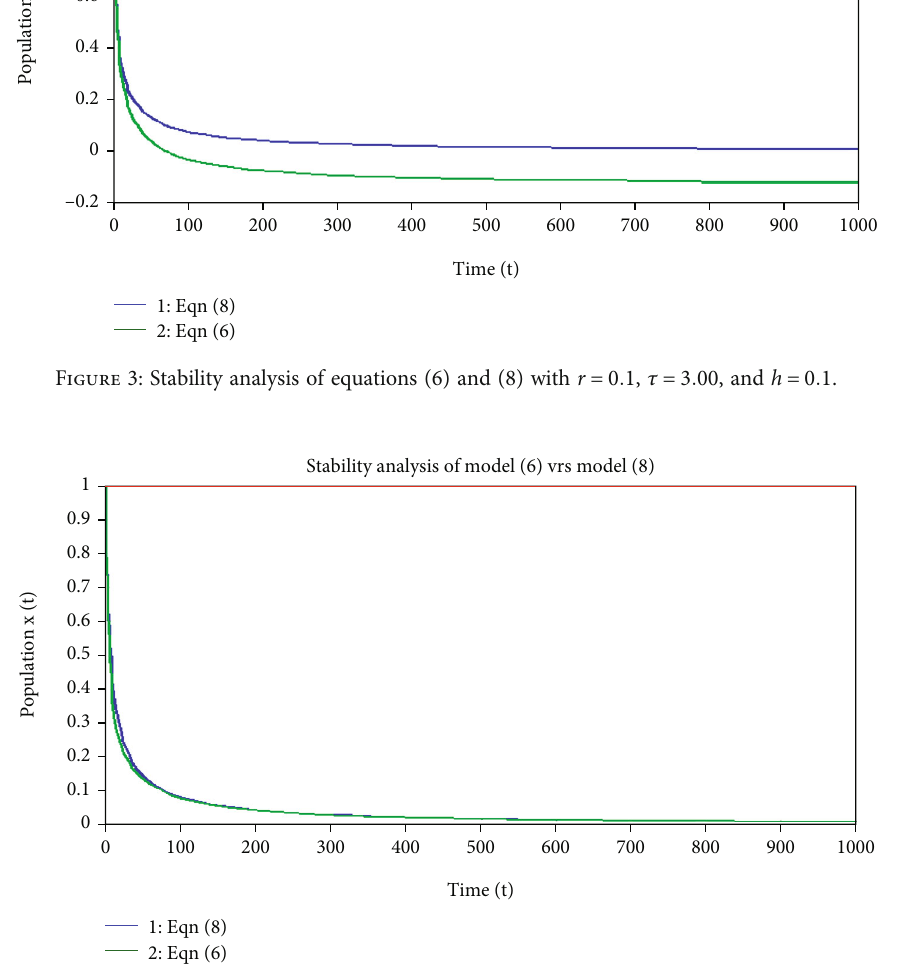
Figure 4: Stability analysis of equations (6) and (8) with r = 0 : 1 , τ = 3 : 00 , and h = 0 : 1